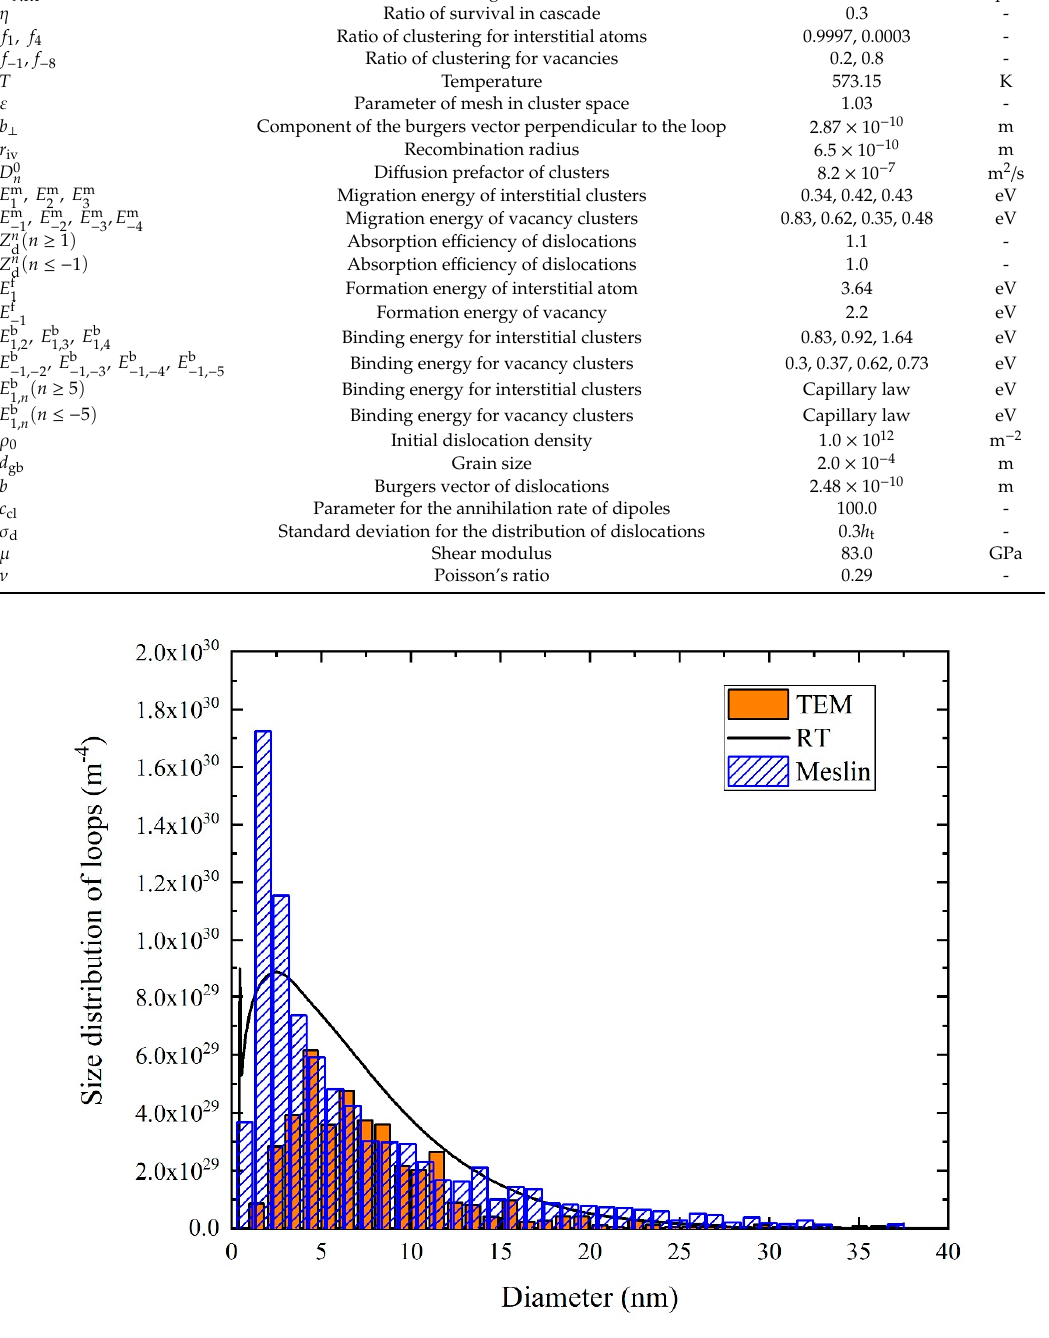
Figure 1. Distribution of dislocation loops in pure iron under neutron irradiation at 0.2 dpa.